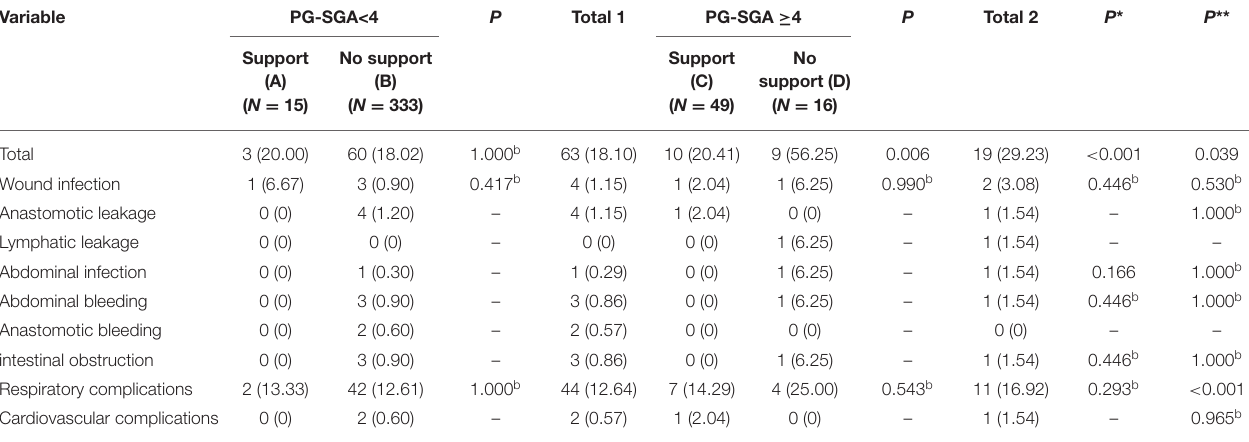
TABLE 3 | Comparison of postoperative complications based on PG-SGA score [ n (%)]. Variable